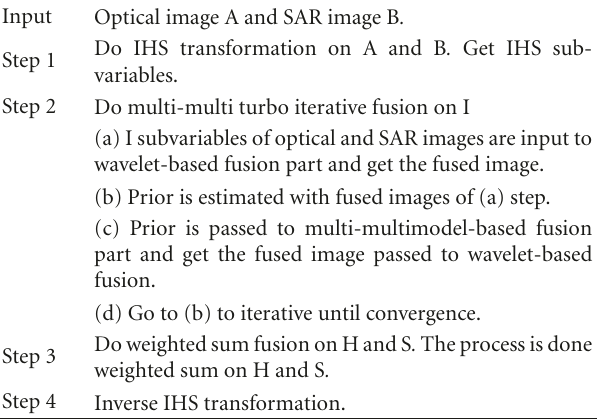
Table 1: Pseudocode of optical and SAR image fusion based on multi-multi turbo iterative.